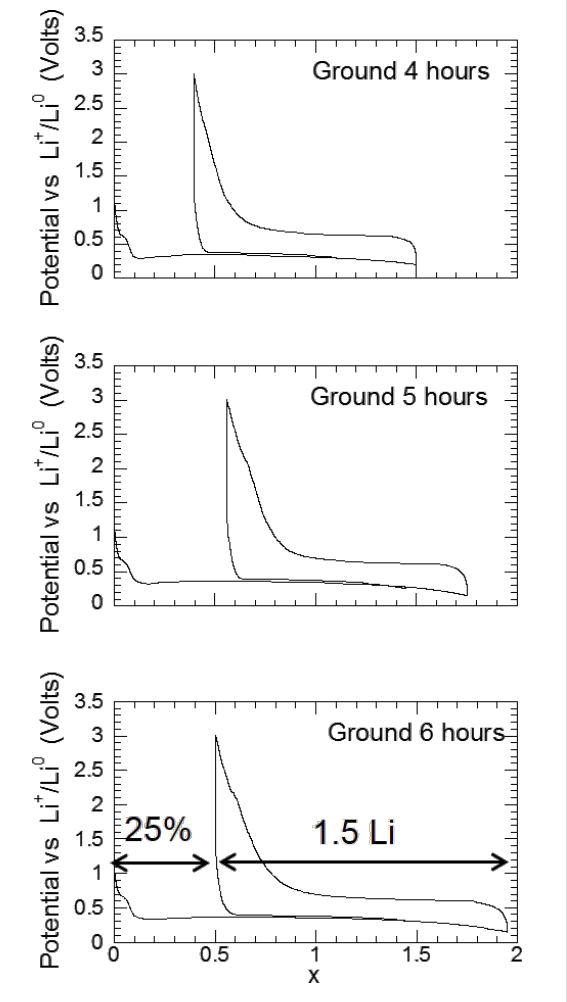
Figure 18: Evolution of the potential (V) as a function of x for a Li/MgH 2 cell that was cycled down to 0.15 V vs Li + /Li 0 at a rate of one equivalent of lithium in 10 h. (MgH 2 is obtained after three absorptions of hydrogen and then ground 4, 5 or 6 h with 10% of C t , z carbon)